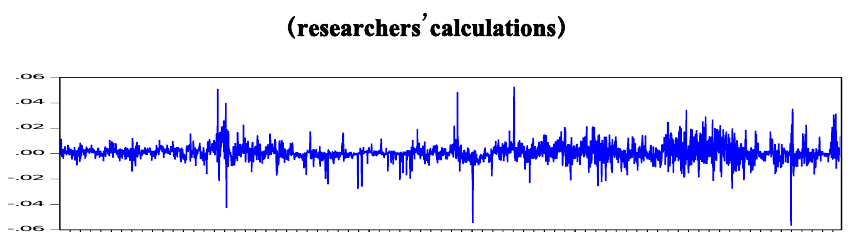
Figure 2: Diagram of return variable’s oscillating trend in Tehran Stock Exchange (researchers’ calculations)